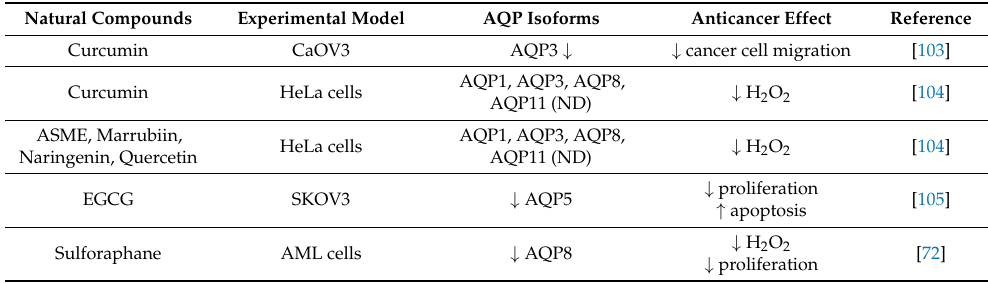
Table 1. Phytochemicals/nutraceutical compounds modulating aquaporins (AQPs) in cancer. Natural Compounds Experimental